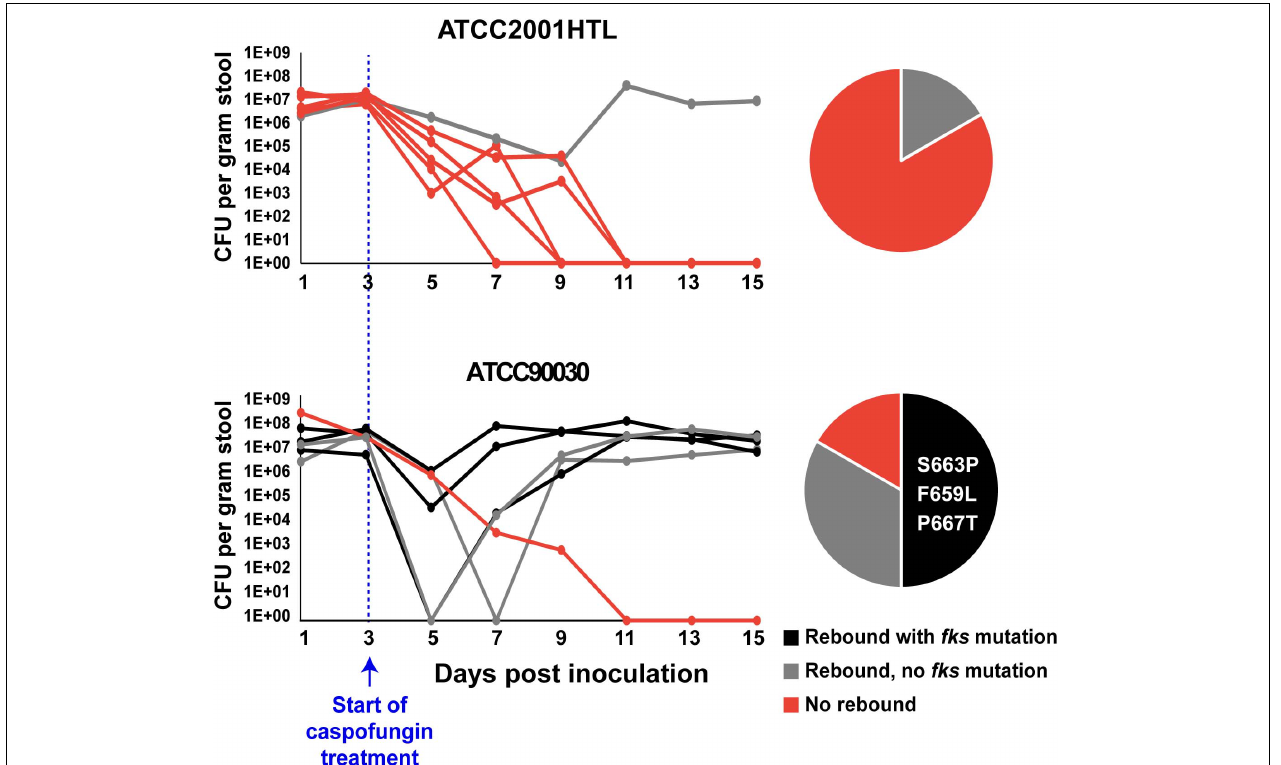
FIGURE 2 | Candida glabrata strain ATCC90030 was more tolerant to caspofungin than strain ATCC2001HTL in the mouse model of gastrointestinal (GI) colonization, leading to a higher rate of rebound and emergence of echinocandin resistant fks -mutants. Six mice per group were colonized with the indicated C. glabrata strains and exposed to daily high-dose caspofungin treatment starting at day 3 post-colonization. CFU per gram of stool were plotted for each day of sample collection, and frequencies for rebound and fks mutations are indicated in pie charts. Zero and three fks -mutants were obtained in ATCC2001HTL